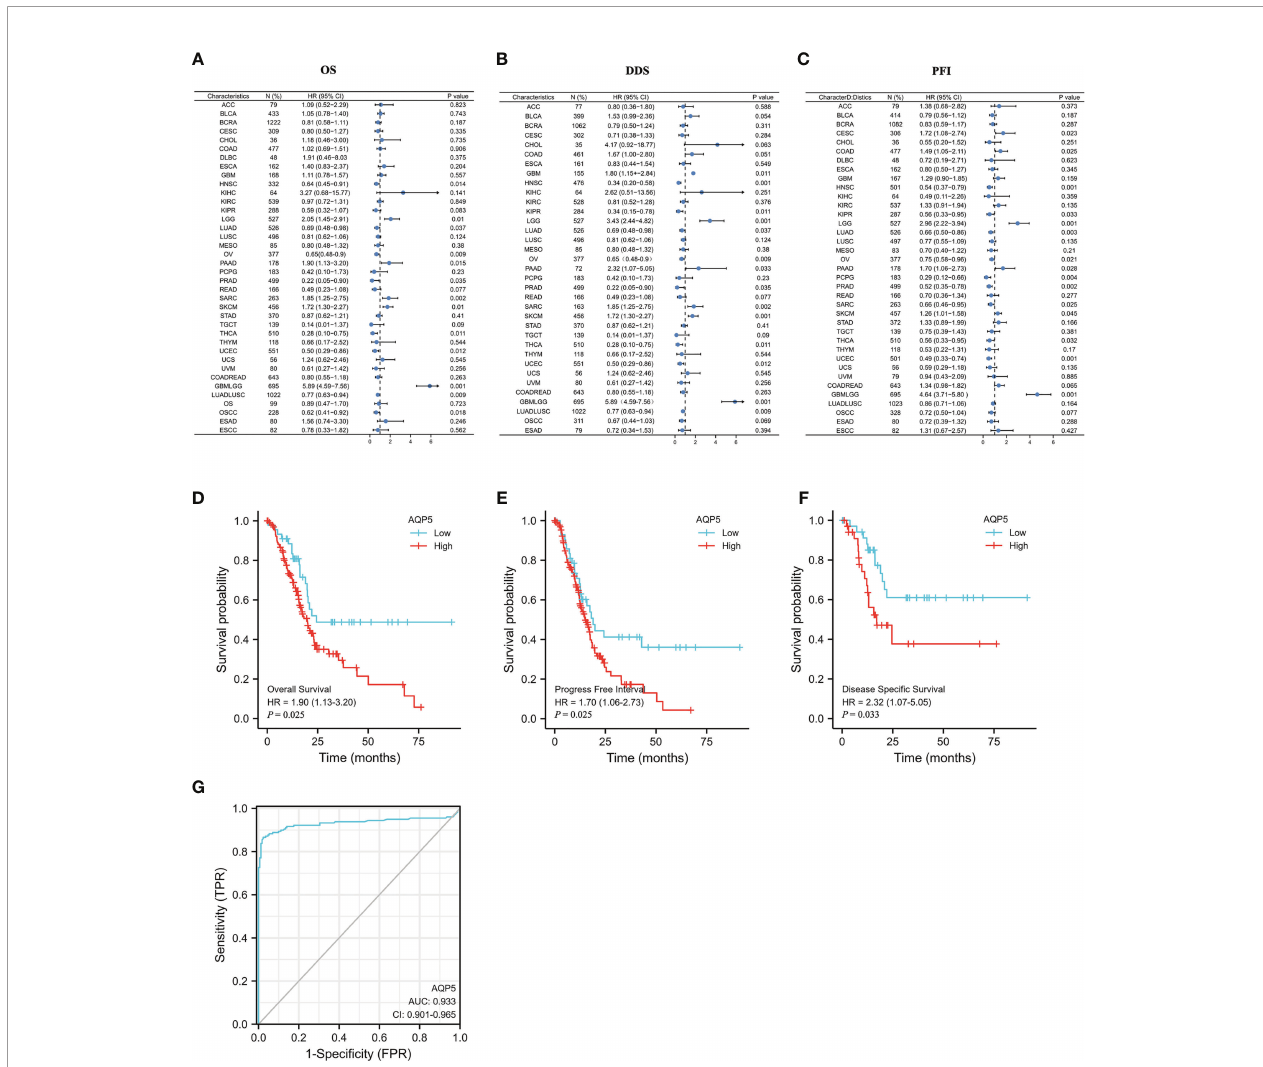
FIGURE 3 | The prognostic value of AQP5 expression in patients with PAAD. (A – C) Forest plot of the prognostic values in different tumor types of AQP5. (D – F) Kaplan – Meier survival analysis revealed that low AQP5 expression in patients with PAAD had a longer overall survival (D) , progression-free interval (E) , and disease-speci fi c survival (F) . (G) The ROC curve of the prognostic values in patients with PAAD of